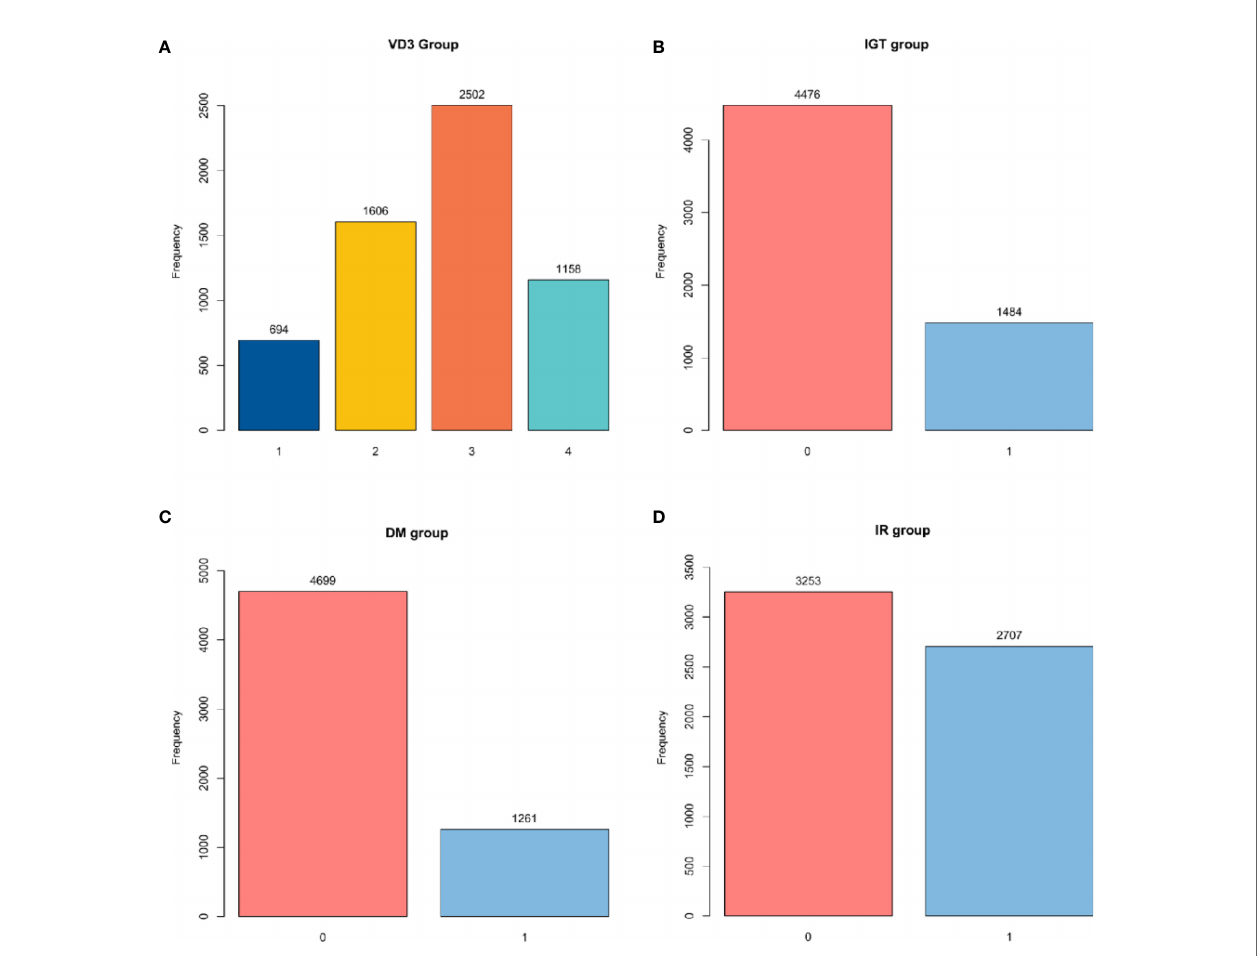
FIGURE 2 | Group diagram of each group. (A) Number of participants in different VD3 groups. (B) Number of participants with or without IGT. (C) Number of participants with or without DM. (D) Number of participants with or without IR. VD3, vitamin D3; IGT, impaired glucose tolerance; DM, diabetes mellitus; IR, insulin